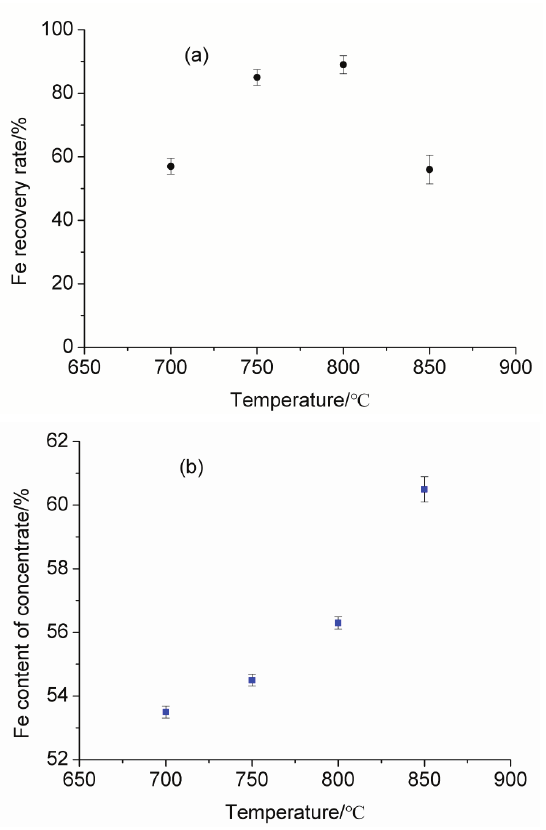
Figure 4: The eff ect of roasting time (50 ~ 80 min) on magnetic roasting result of (a) Fe recovery, and (b) Fe content of fi nal